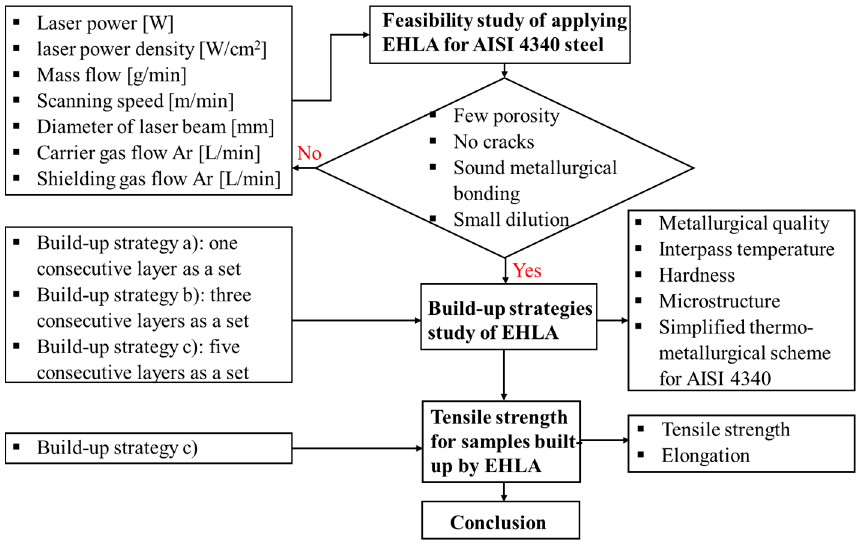
Figure 1. Flow chart of experimental development.